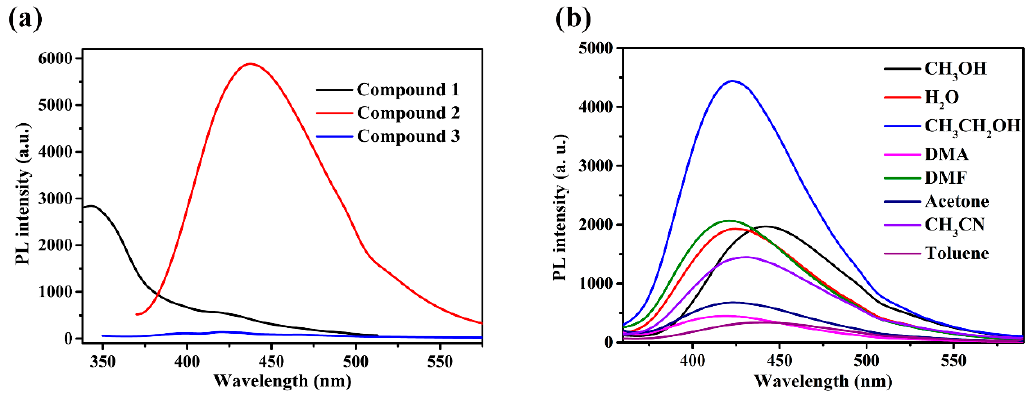
Figure 6. ( a ) Fluorescence spectra of compounds 1 – 3 in the solid state. ( b ) Fluorescence spectra of compound 2 in different solvents.